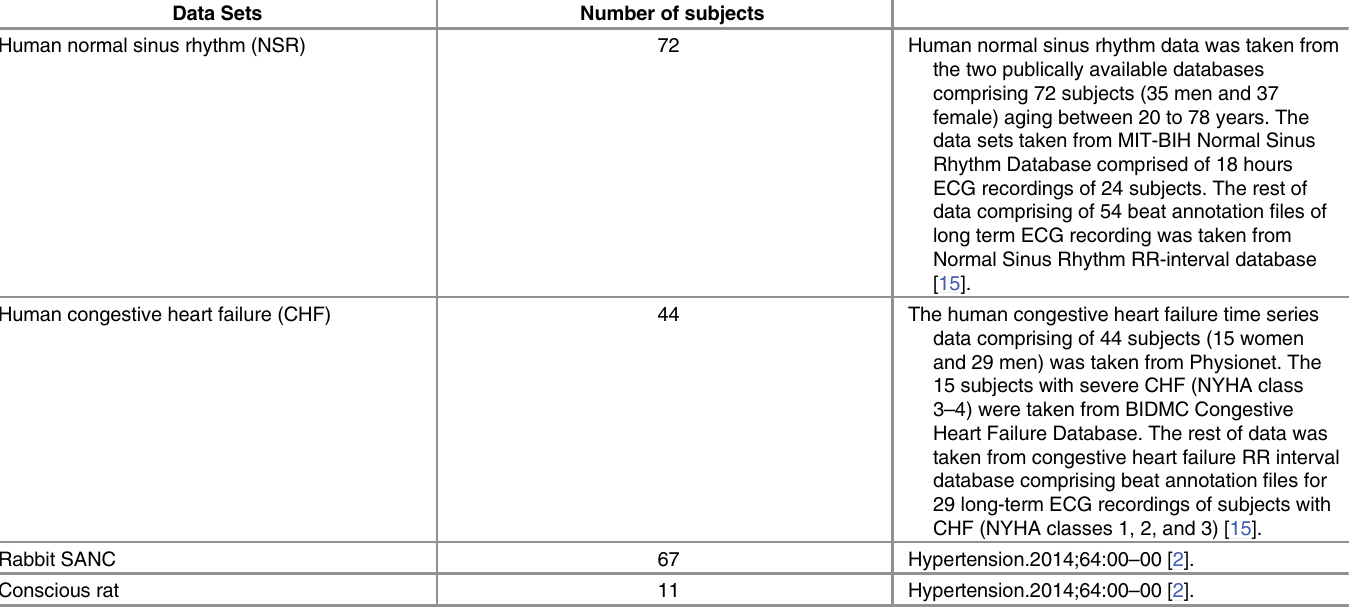
Table 1. R-wave to R-wave interval data sets used in the